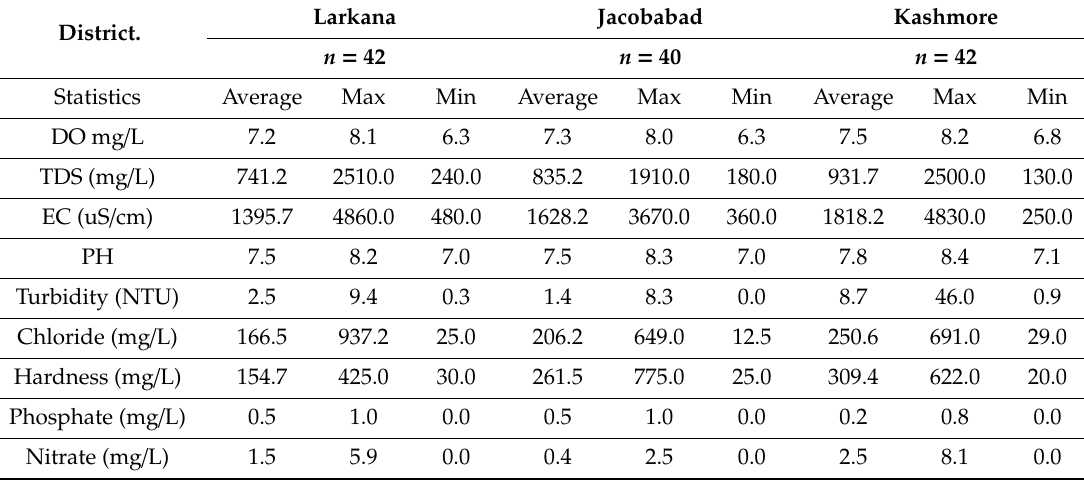
Table 5. Water quality parameters of North